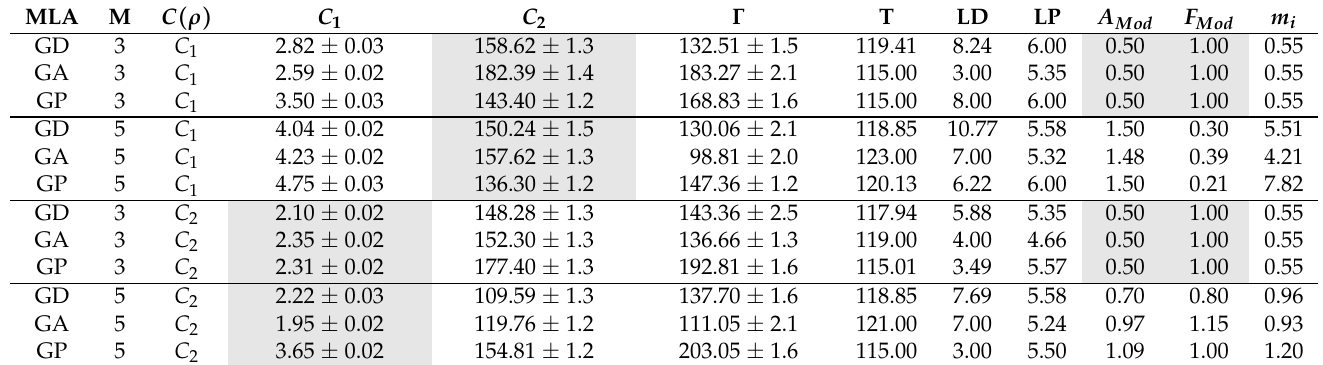
Table 2. Optimal parameters found for the following optimisation techniques, Genetic Algorithm (GA), Gradient Descent algorithm (GD) and Gaussian process (GP). The number of parameters tested, M , is specified for each optimisation run. T, cell temperature ( ◦ C ). LP, laser power (mW). LD, laser detuning (GHz). A Mod , modulation amplitude factor (dimensionless). F Mod , modulation frequency factor (dimensionless). m i , modulation index (dimensionless). C ( ρ ) defines the cost function implemented. C 1 is the demodulated lineshape gradient (mV/nT), with uncertainty taken as the geometric standard deviation across the frequency band of interest. C 2 is the calculated sensitivity (fT/ √ Hz), with uncertainty taken as the linear fitting error across demodulated linear region. Γ is the full-width at half-maximum (FWHM) of the magnetic resonance (nT), with uncertainty taken as the fit error to Equation (2). Values in grey indicate parameters that were not optimised during